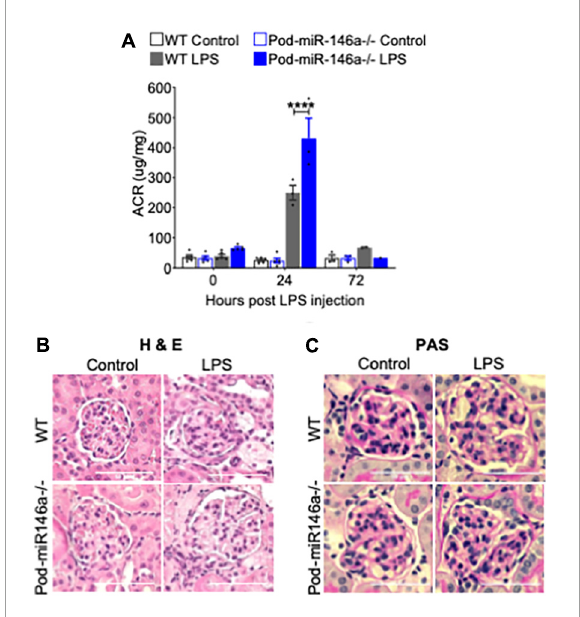
FIGURE2 Pod-miR-146a mice show increased impairment of kidney function in response to LPS. (A) Graph showing the albumin to creatinine ratio ( µ g/mg) in the urine of WT (gray bars) and Pod-miR-146a (blue bars) mice after 0, 24, and 72 h post administration of either vehicle (open bars) or LPS (shaded bars). Statistics were performed using two-way ANOVA. Data shown are mean ± SEM ( n = 5). **** p < 0.0001. (B,C) Representative images showing histochemical analyses with hematoxylin-eosin (H&E), periodic acid-Schiff (PAS) staining of kidney tissues from 24 h post LPS treatment. Scale bar, 50 µ